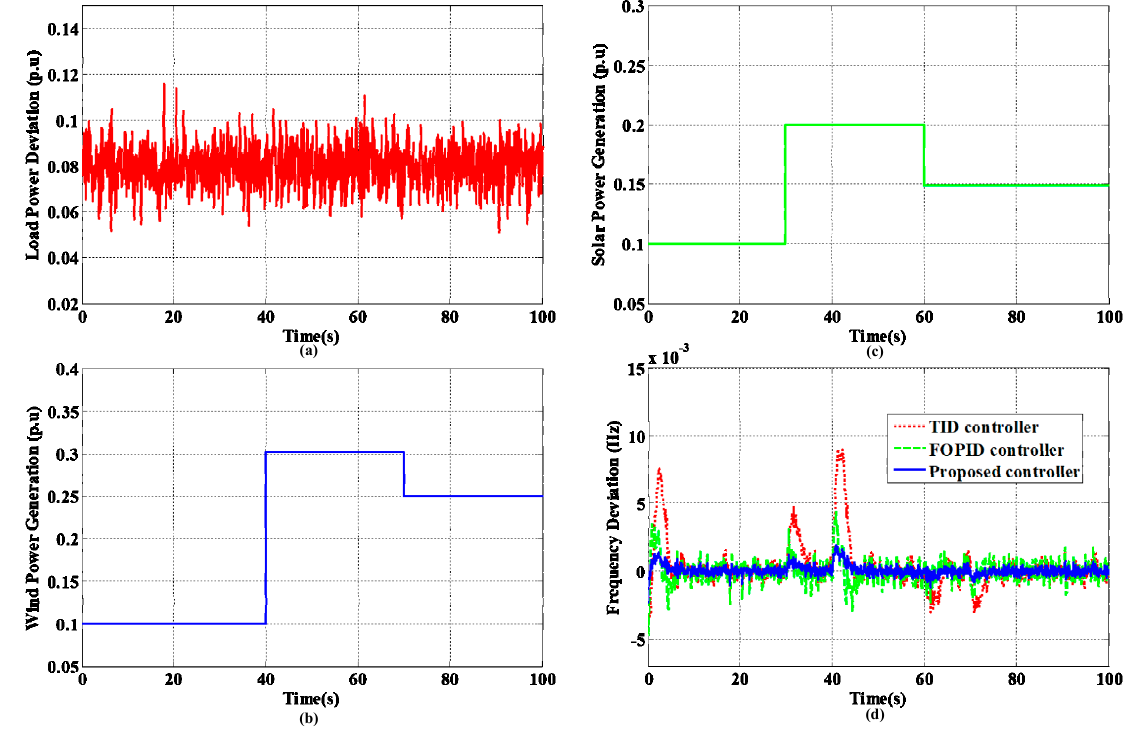
Figure 11. MG disturbances and frequency response for scenario 5.1.3. ( a ) Random load deviation pattern. ( b ) WTG output power. ( c ) PV output power. ( d ) Resulted frequency responses.